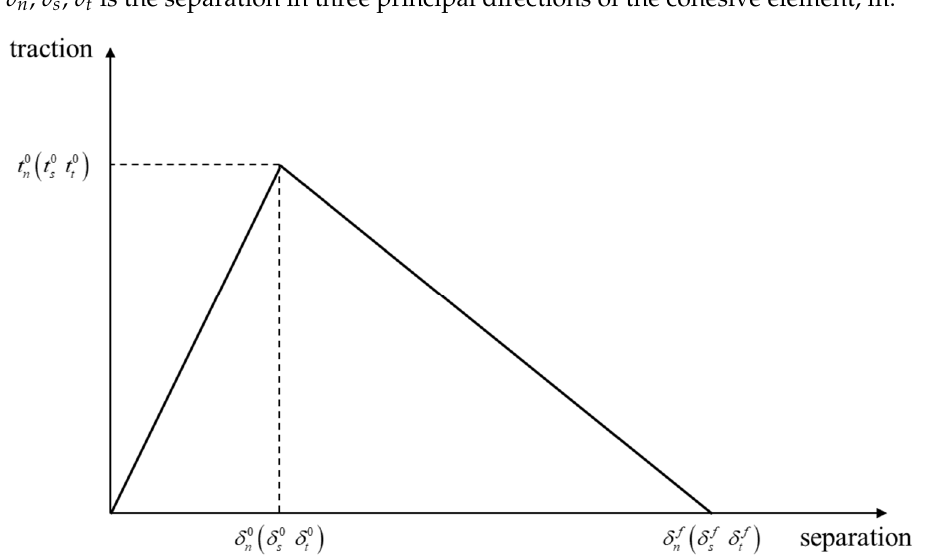
Figure 2. The relationship between traction and separation.